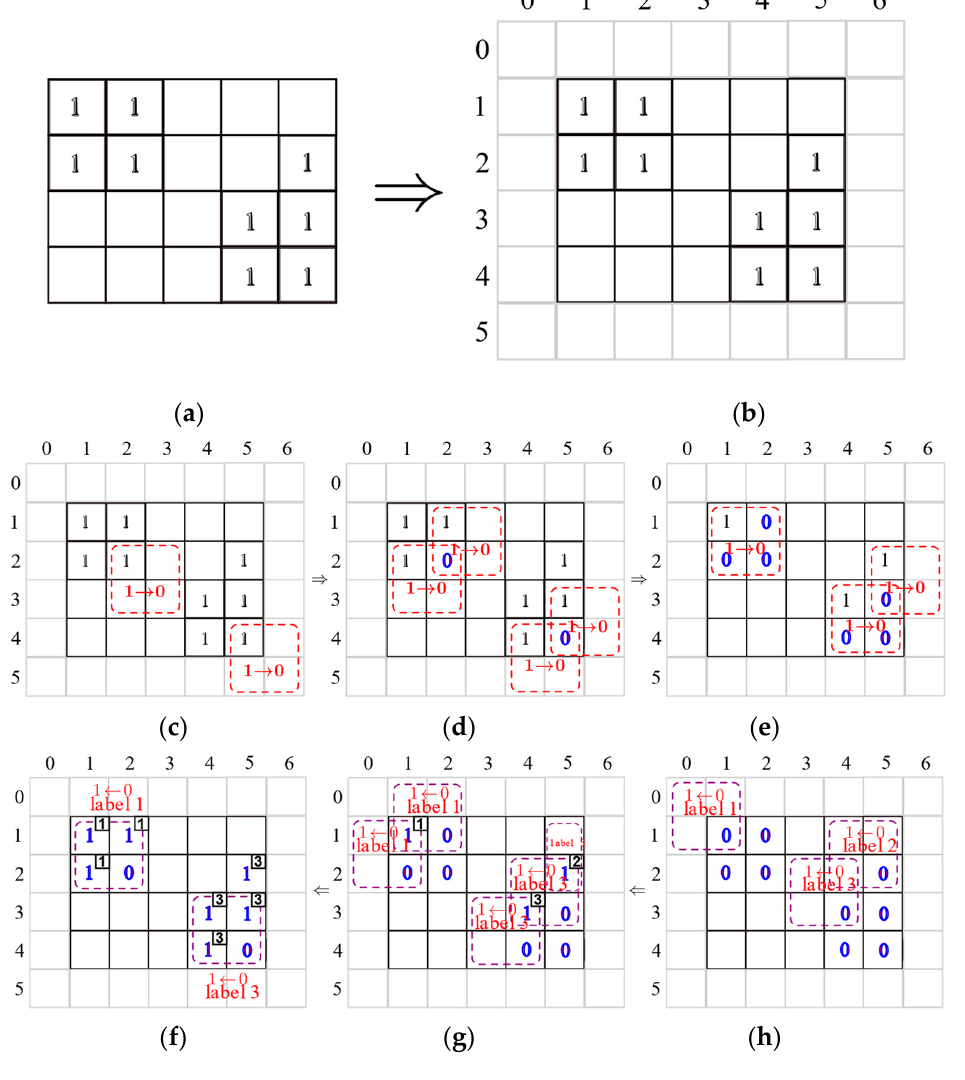
Figure 2. The simple example of local-operator techniques. ( a ) original image. ( b ) adding border. ( c ) partial result 1. ( d ) partial result 2. ( e ) partial result 3. ( f ) propagate 3. ( g ) propagate 2. ( h ) propagate 1. Phase 1 Preparation: When every pixel has its N s and N p neighbors, the original image is extended by a 1-pixel outer border that pads the border of the image with white. The white pixels (0 value) are ignored in the board so that we can focus better on changes in the black regions (1 value), as shown in Figure